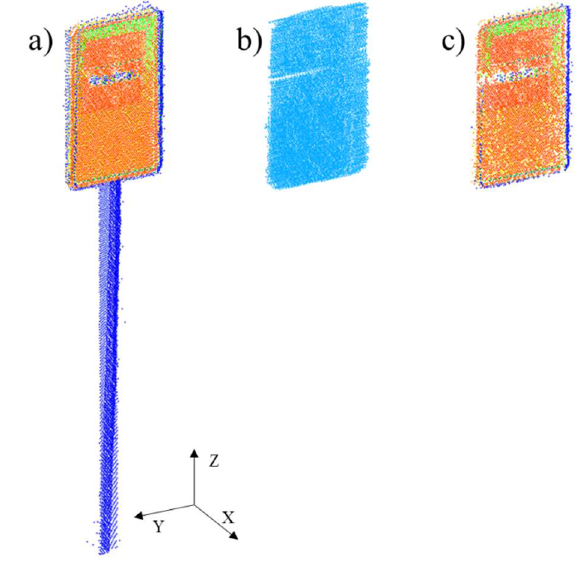
Figure 6 . Morphological opening for traffic sign segmentation: a) input point cloud, b) traffic sign segmented point cloud, c) traffic sign segmented point cloud with retrieval